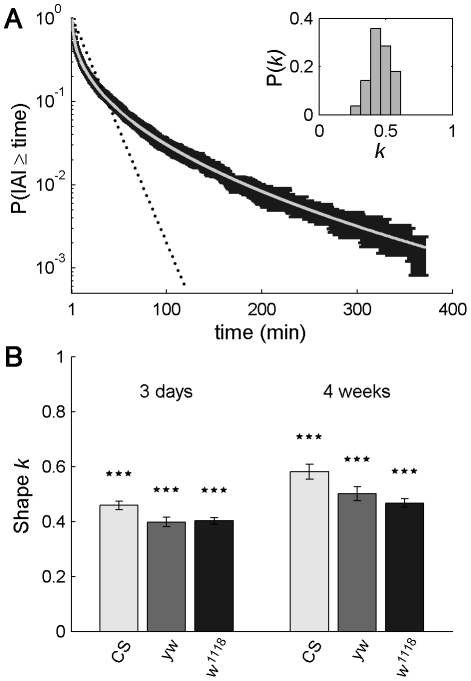

Drosophila inter-activity intervals (IAIs) follow the Weibull distribution.(A) Mean IAI survival distribution of 28 Canton-S flies during the dark period (black, mean ± standard error) shows a clear deviation from the exponential distribution corresponding to the IAIs of a Poisson process (dotted line, same mean as actual IAI distribution). The Weibull distribution (light grey line) fits data accurately (r2 = 0.998), with k = 0.45, λ = 6.0. Individual flies also have IAIs following the Weibull distribution. Inset: Distribution of k values obtained for the same data set but performing individual fits (mean fit r2 = 0.92±0.07 s.e.m.). Each fly shows bursty dynamics with k = 0.46±0.08 s.e.m. (B) Shape parameter k for young (3 days, left) and adult (4 weeks, right) Canton-S (CS) flies, yellow-white (yw) and w1118 flies. All show bursty dynamics, with k<1, significantly different from the Poissonian k = 1 case with p<10−7. Day and night data are treated separately as the activity dynamics are different; in Figure S1A we present the corresponding daily activity patterns for the 3-day-old CS, yw and w1118. Number of flies n = 28–32.